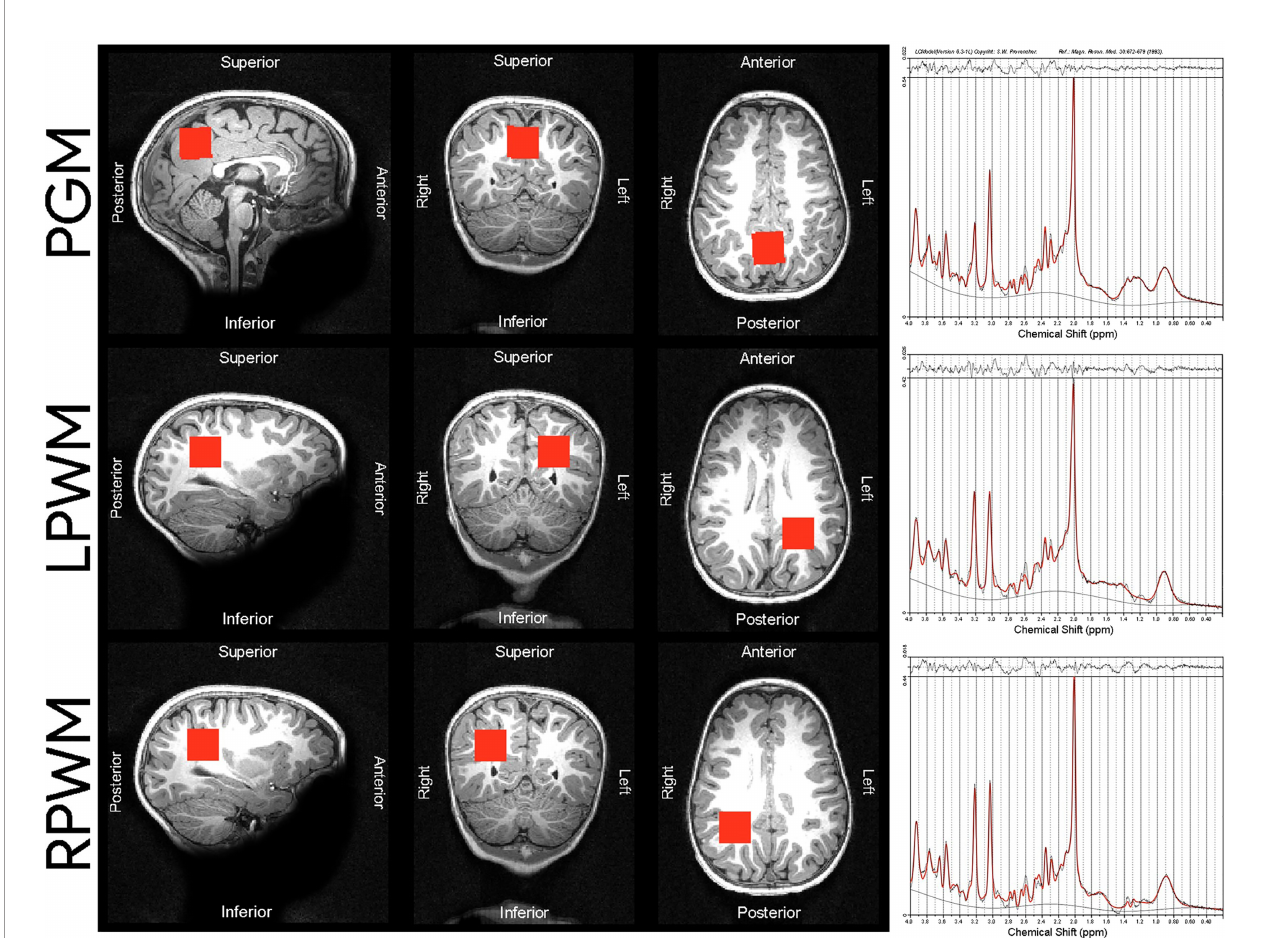
FIGURE 1 | Voxel placements and sample spectra of median SNR and LCModel output from the 3T scanner used in our cohort of children. The following median SNR were obtained for each voxel placement: PGM median SNR = 34, LPWM median SNR = 35, RPWM median SNR = 33. PGM, parietal grey matter; LPWM, left parietal white matter; RPWM, right parietal white matter; SNR, signal-to-noise ratio; ppm, parts per